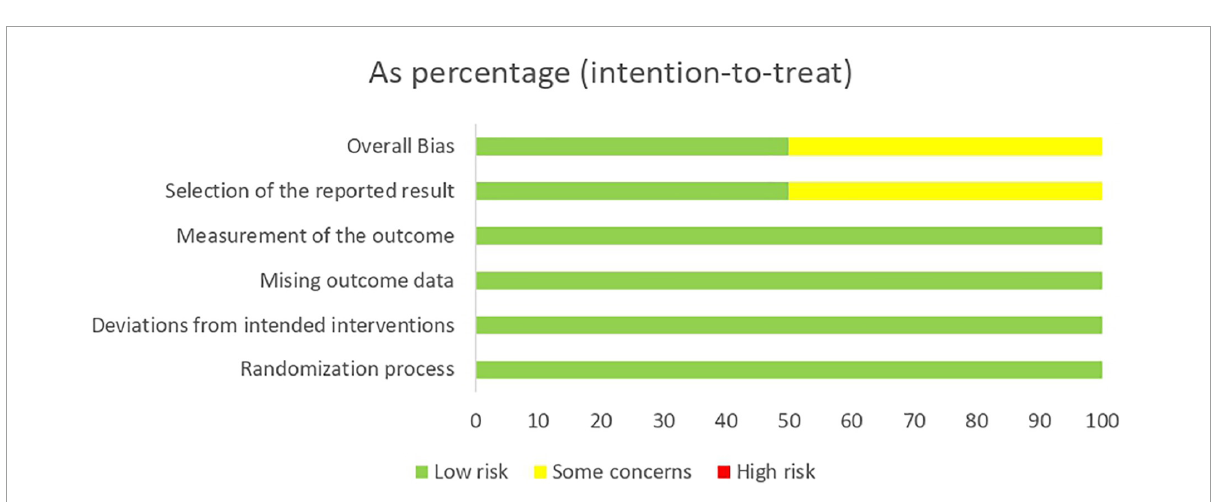
FIGURE3 Risk of bias of randomized clinical trials included and evaluated through RoB